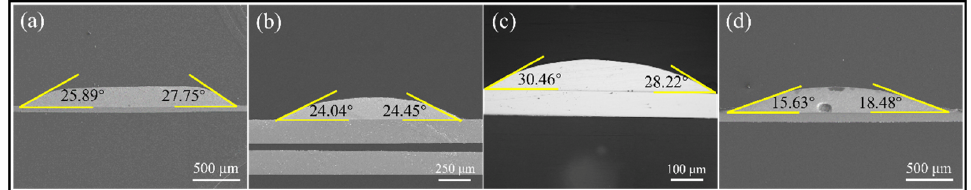
Figure 10. Wetting angle: ( a ) 13.5Sn-37.5Bi-45In-4Pb quaternary eutectic solder paste; ( b ) SAC305 solder ball; ( c ) Sn58Bi solder paste; ( d ) the fully mixed solder of 13.5Sn-37.5Bi-45In-4Pb quaternary eutectic solder paste and SAC305 solder